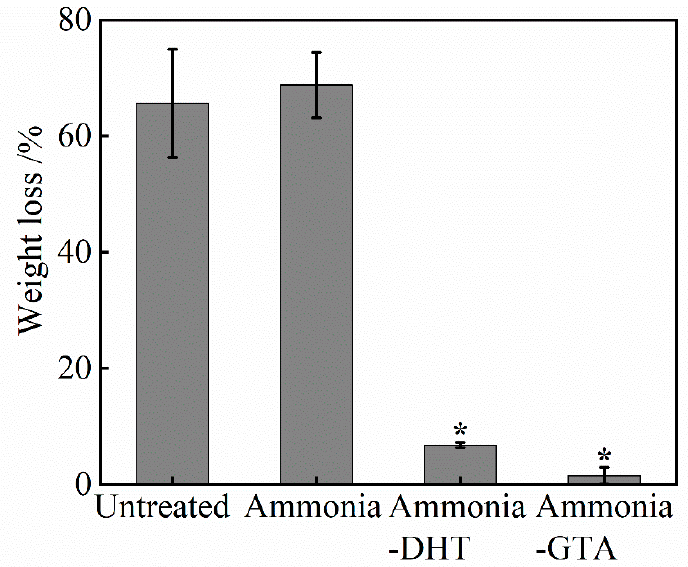
Figure 8. Weight loss of collagen tubes before and after various treatments. * p < 0.05, crosslinked collagen tubes are significantly different from untreated collagen tube.